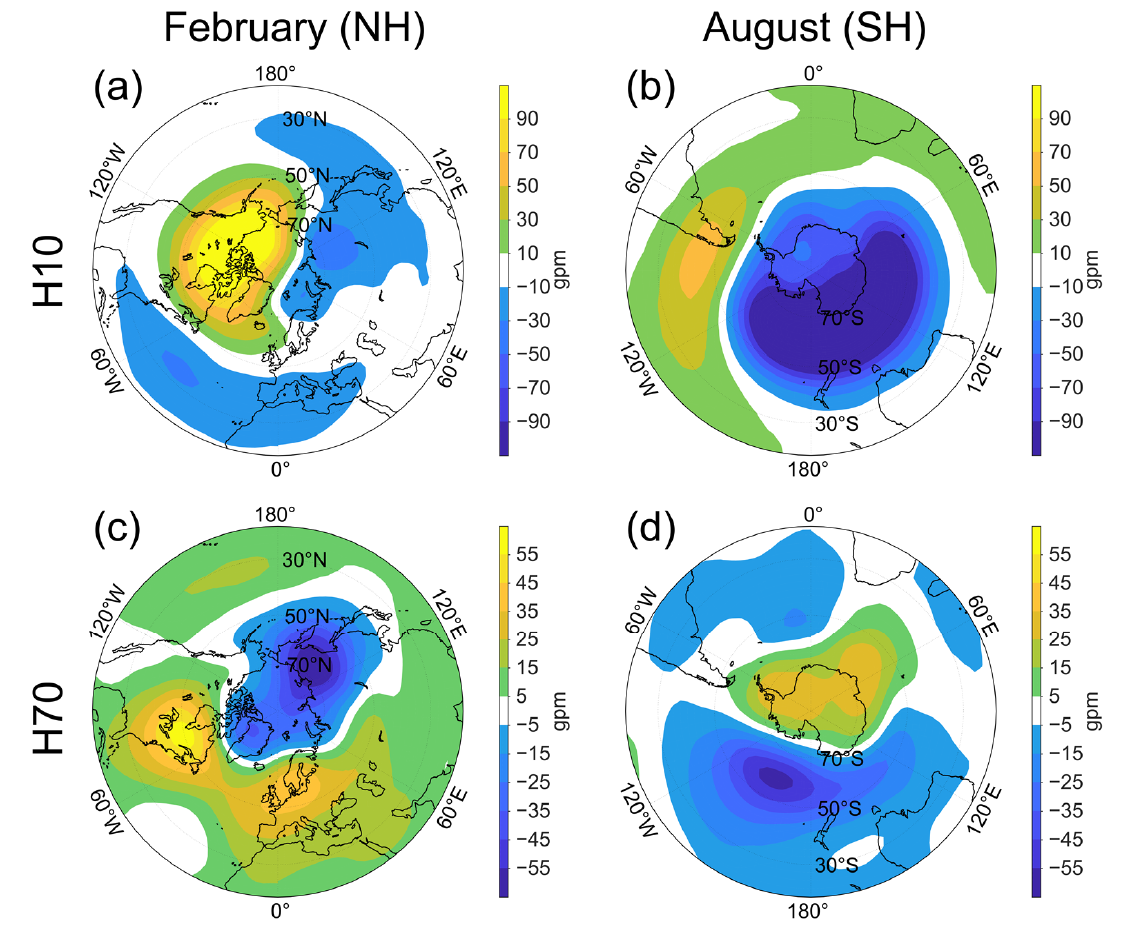
Figure 15. Top panel: difference between geopotential height regression onto E and C + indices in the middle stratosphere ( a ) for February in the Northern Hemisphere and ( b ) for August in the Southern Hemisphere. Bottom panel: the same but in the lower stratosphere ( c , d ). Contour interval is 20 gpm in panels ( a , b ) and 10 gpm in panels ( c , d ).